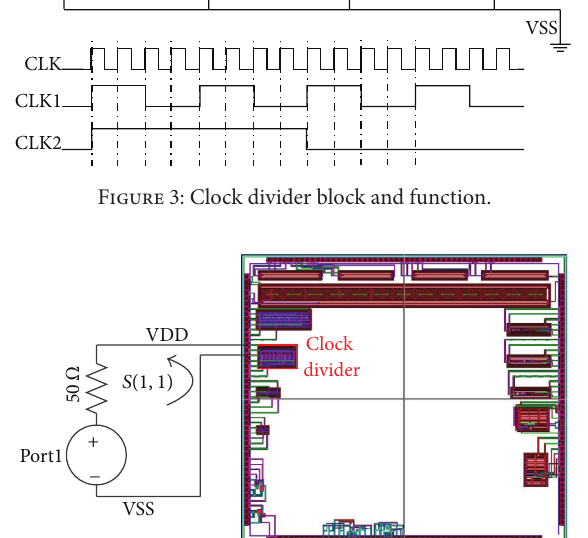
Figure 4: IC parameter extraction set-up.